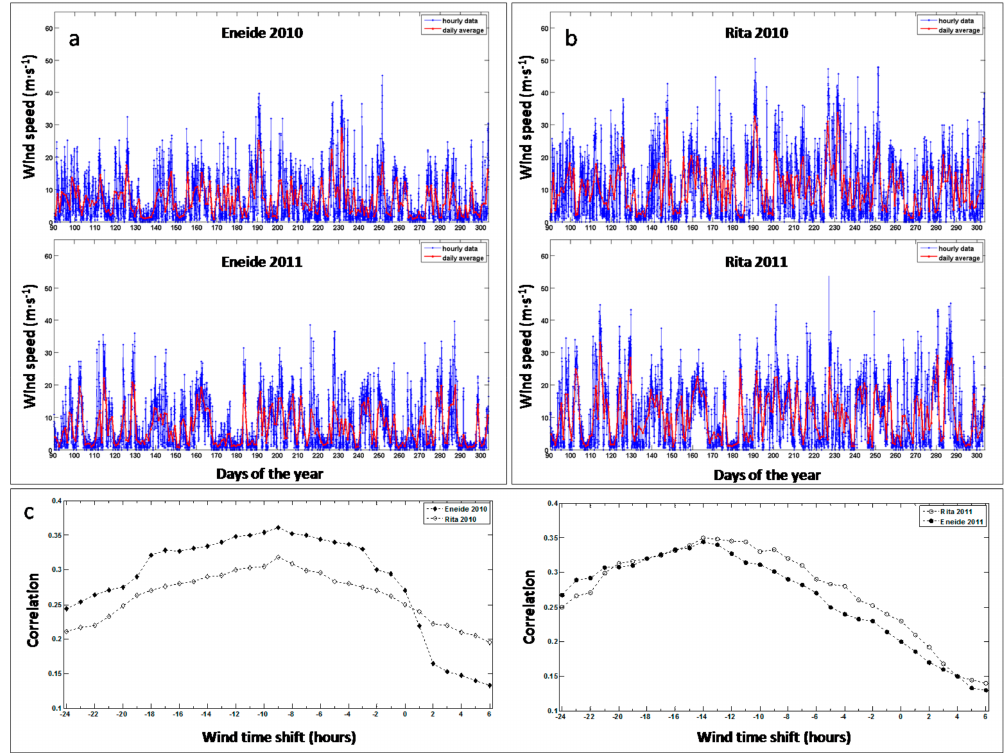
Figure 5. Wind speed records acquired by ( a ) AWS Eneide and ( b ) AWS Rita during wintertime 2010 and 2011; blue dots identify hourly observations, red dots represent the daily average; ( c ) correlations of AWS Eneide and Rita wind speed measurements with corresponding MODIS derived Terra Nova Bay polynya extents, estimated with moving time shifts of the wind